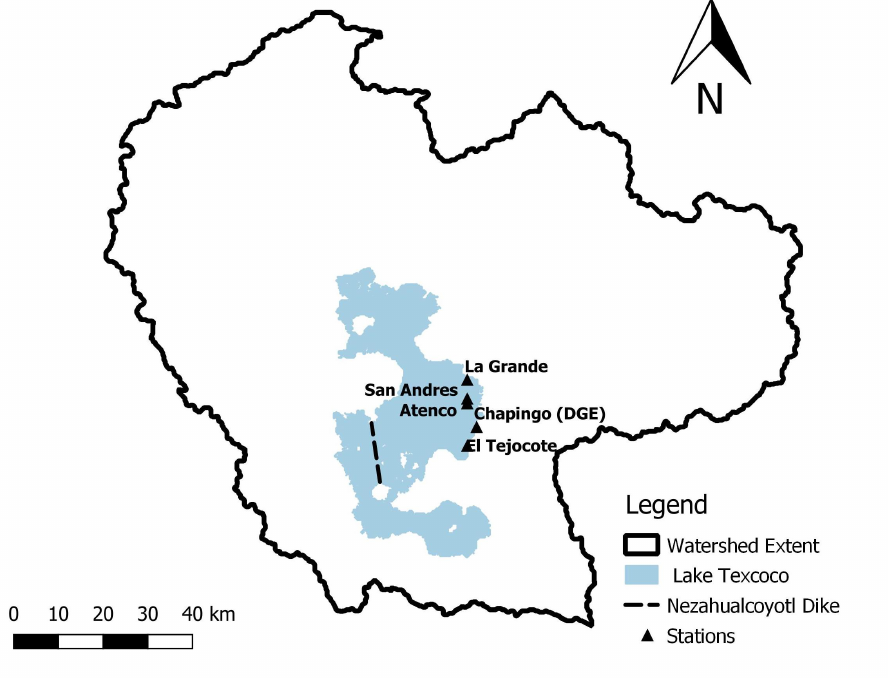
Figure 5. Outline of the study area. Reconstructed from information taken from